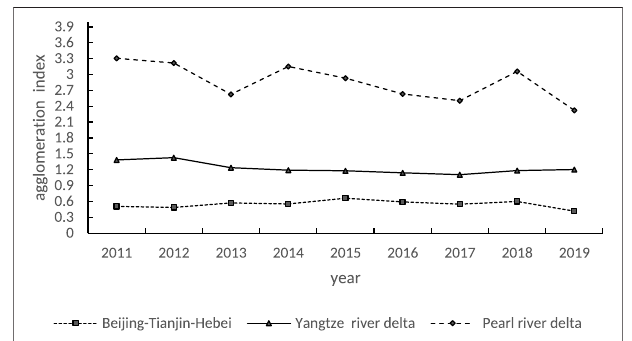
FIGURE 3 | High-tech manufacturing agglomeration.